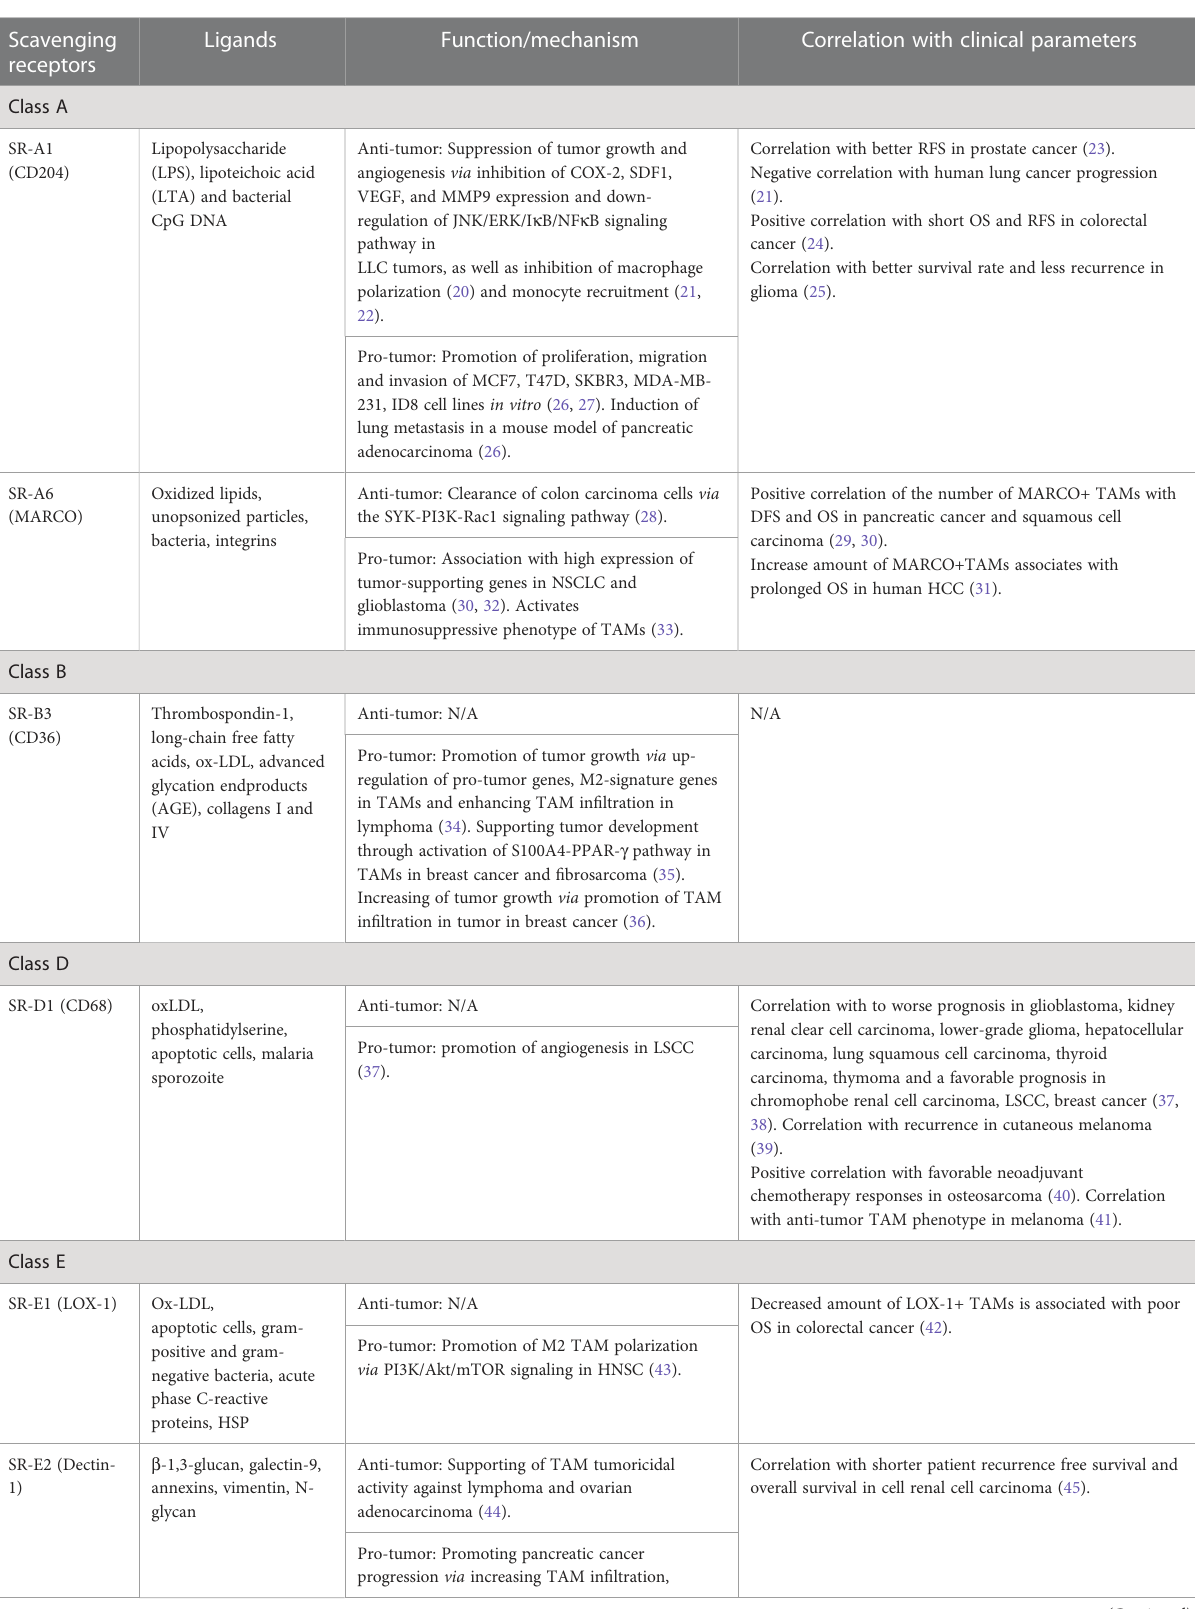
Correlation with better RFS in prostate cancer (23). Negative correlation with human lung cancer progression (21). Positive correlation with short OS and RFS in colorectal cancer (24). Correlation with better survival rate and less recurrence in glioma